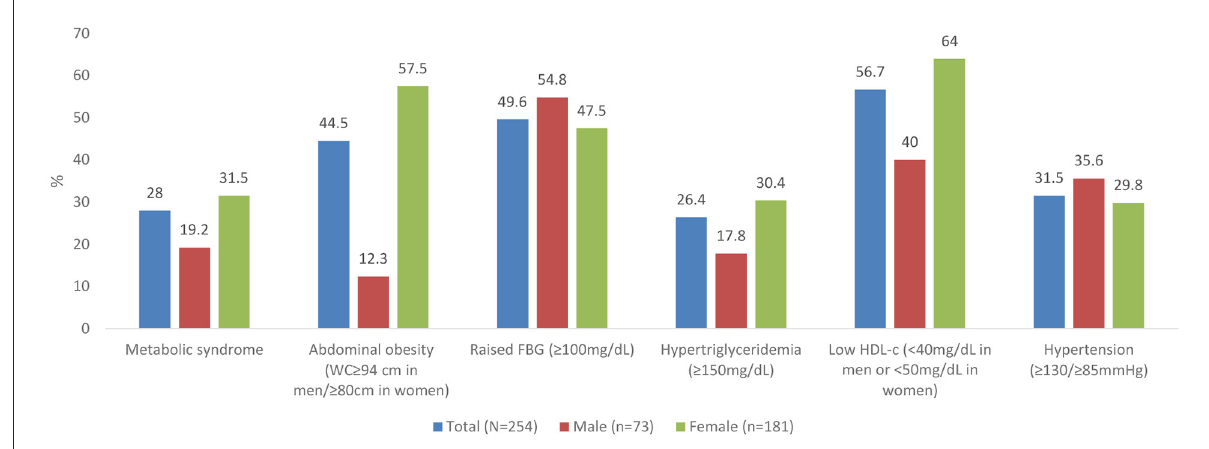
FIGURE1 Prevalence of metabolic syndrome and its components. WC, waist circumference; FBG, Fasting Blood Glucose; HDL, High Density Lipoproteins.